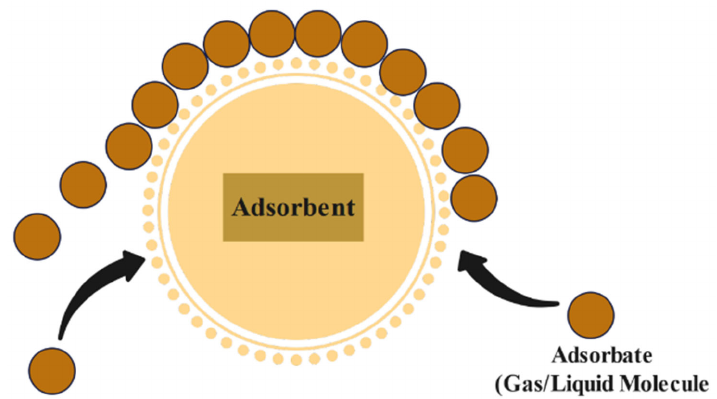
Figure 6. Adsorption technique [85].